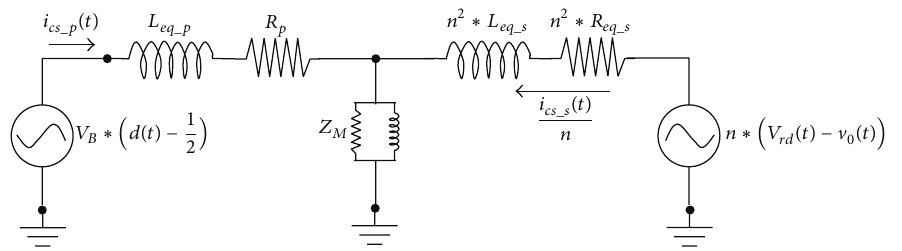
Figure 5: Simplified averaged circuit of the series